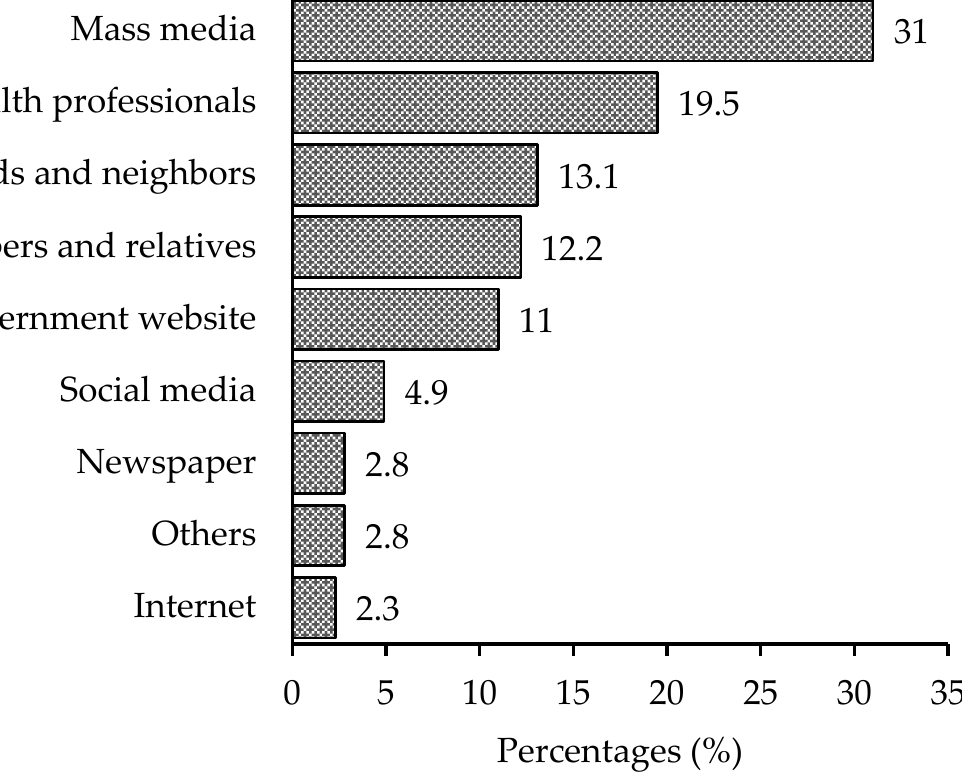
Figure 1. Sources of knowledge regarding COVID-19 among the participants.